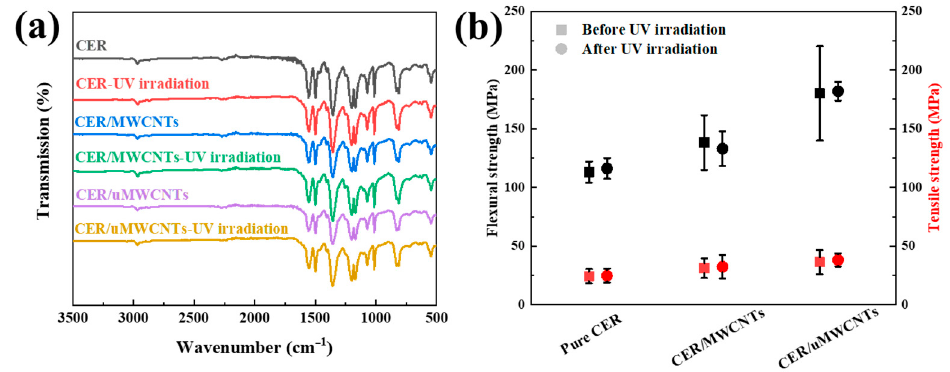
Figure 10. FTIR spectra ( a ), mechanical properties ( b ) of the pure CER network, CER/MWCNTs and CER/uMWCNTs nanocomposites before and after UV irradiation. CER/uMWCNTs nanocomposites before and after UV